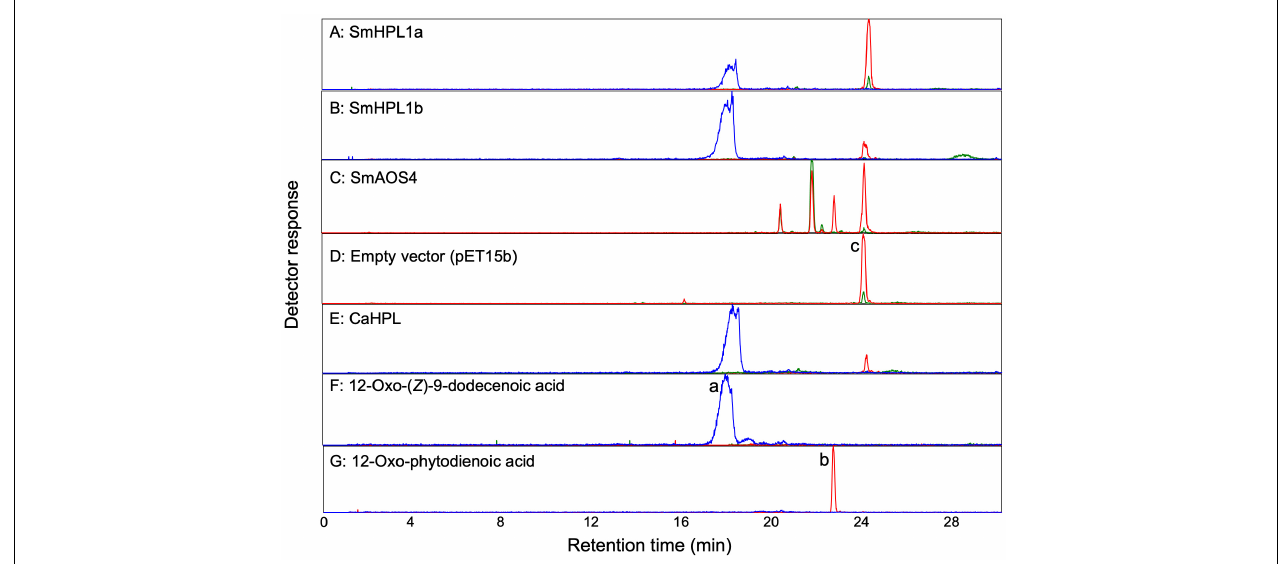
FIGURE 4 | LC-MS/MS analyses of products formed by (A) recombinant SmHPL1a, (B) recombinant SmHPL1b, (C) recombinant SmAOS4, (E) recombinant bell pepper HPL (CaHPL) from 13HPOT. As the empty vector control, the membrane fraction of the E. coli cells harboring pET15b was reacted with 13HPOT (D) . Authentic standards of 12-oxo-( Z )-9-dodecenoic acid (peak a) (F) and 12-oxo-phytodienoic acid (OPDA) (peak b) (G) were also analyzed. The substrate, 13HPOT, is shown with peak c. The red trace shows extracted ion chromatograms with m/z of 291.2 ± 0.5 for hydroperoxides of linolenic acid [M-H 3 O + ] − , 12-oxo-phytodienoic acid [M-H + ], or colnelenic acid [M-H + ] − . The blue trace is with m/z of 211.1 ± 0.5 for 12-oxo-( Z )-9-dodecenoic acid [M-H + ] − . The green trace is with m/z of 309.2 ± 0.5 for hydroperoxides of linolenic acid [M-H + ] − , α - and γ -ketols [M-H + ] − , or epoxy alcohol [M-H + ] − .